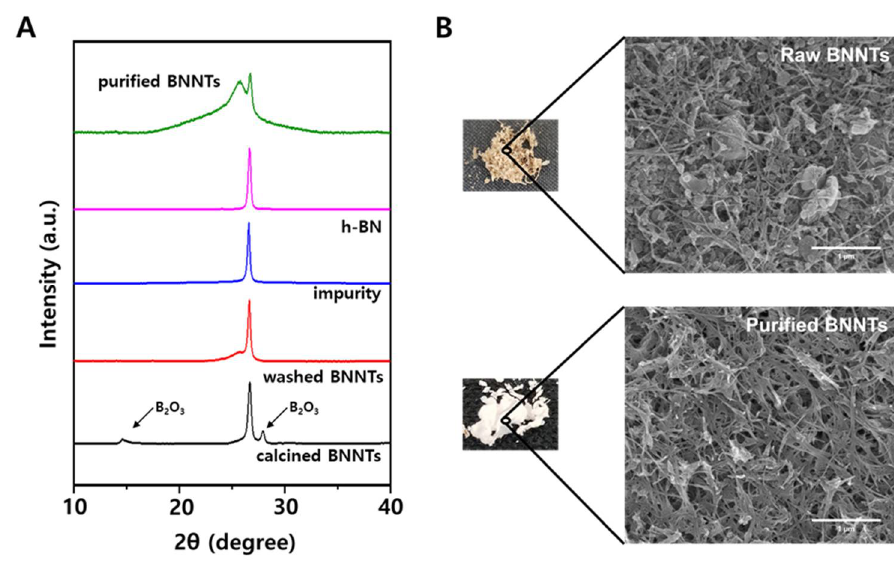
Figure 2. ( A ) X-ray diffraction spectrum and ( B ) SEM images of before and after the purification of boron nitride nanotubes.